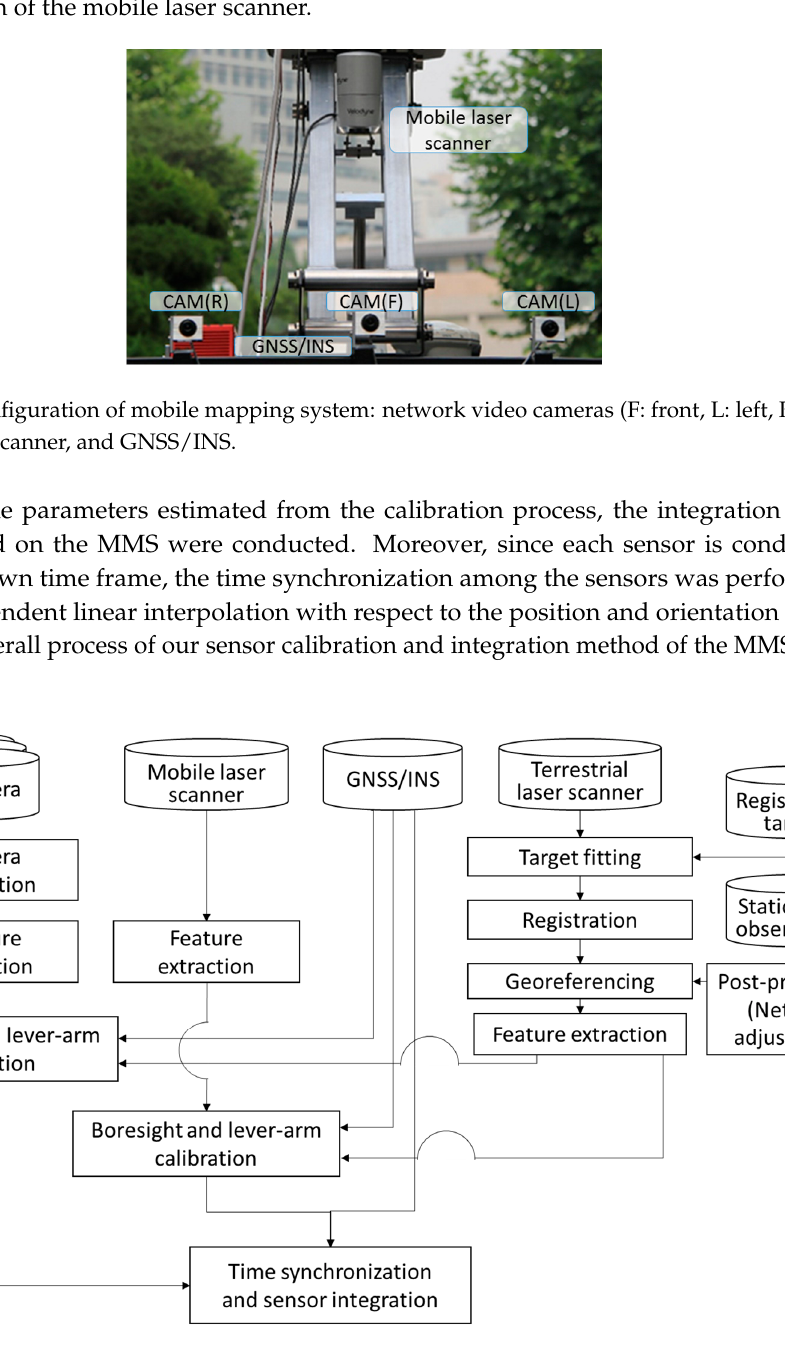
Figure 2. Sensor calibration and integration scheme of mobile mapping system.